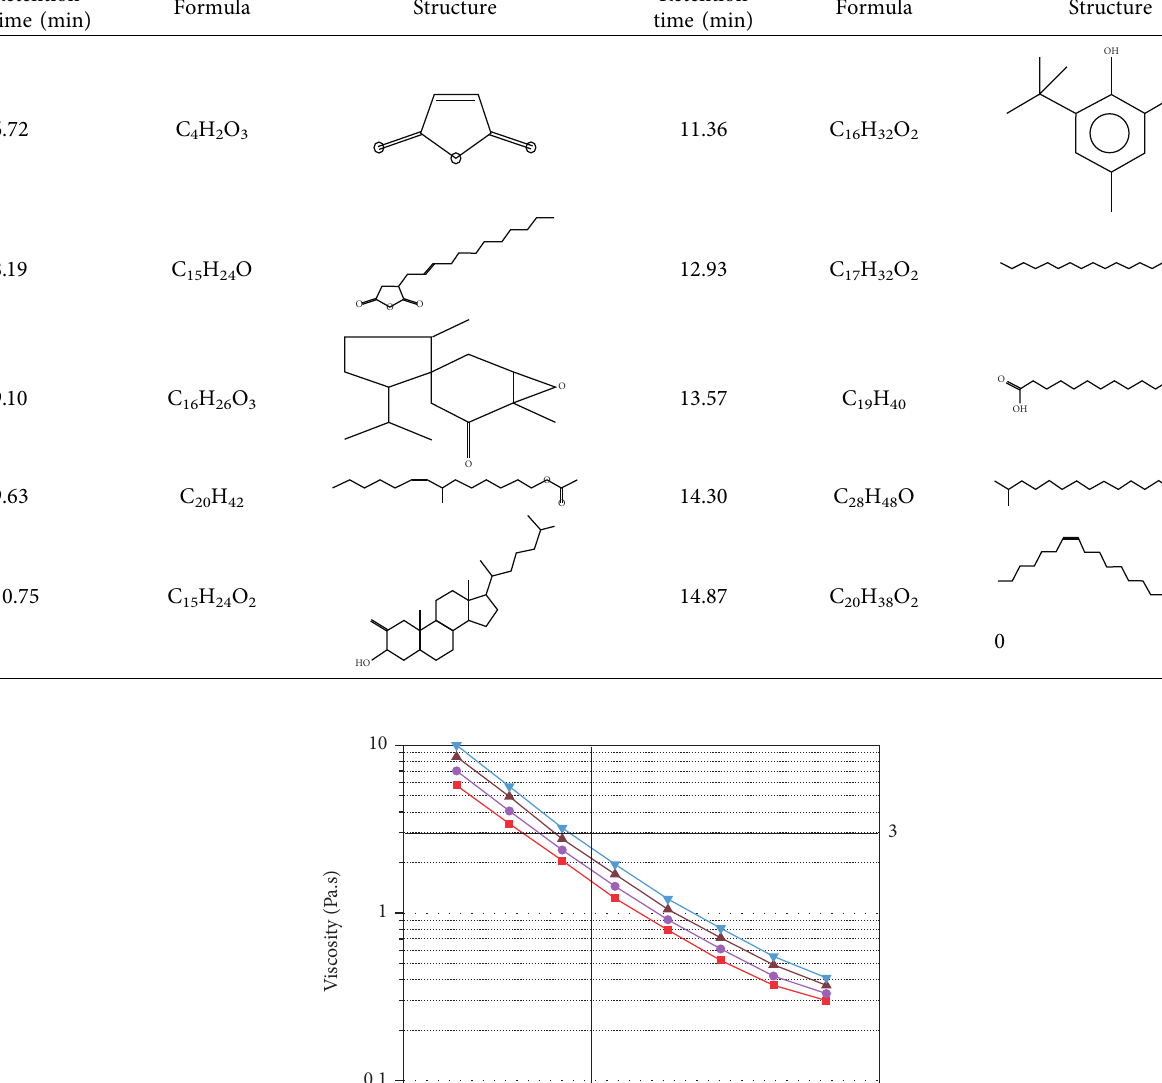
Table 4: The chemical composition of WEOB.